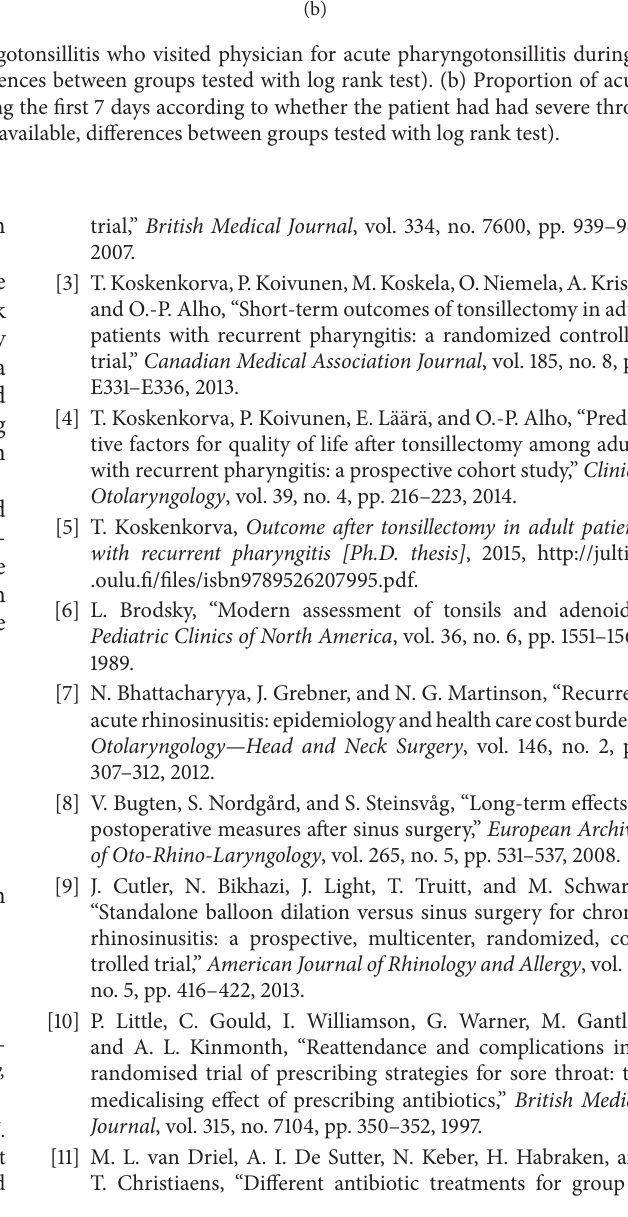
occurred before or after tonsillectomy did not correlate with a medical